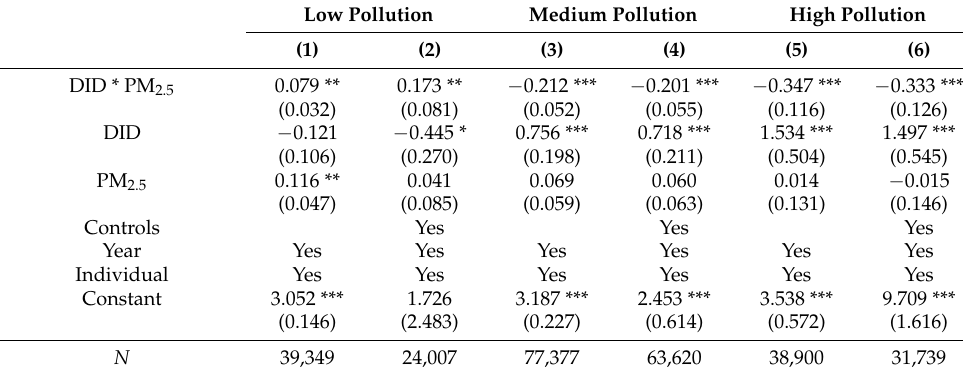
Table 7. Mechanism analysis—envy